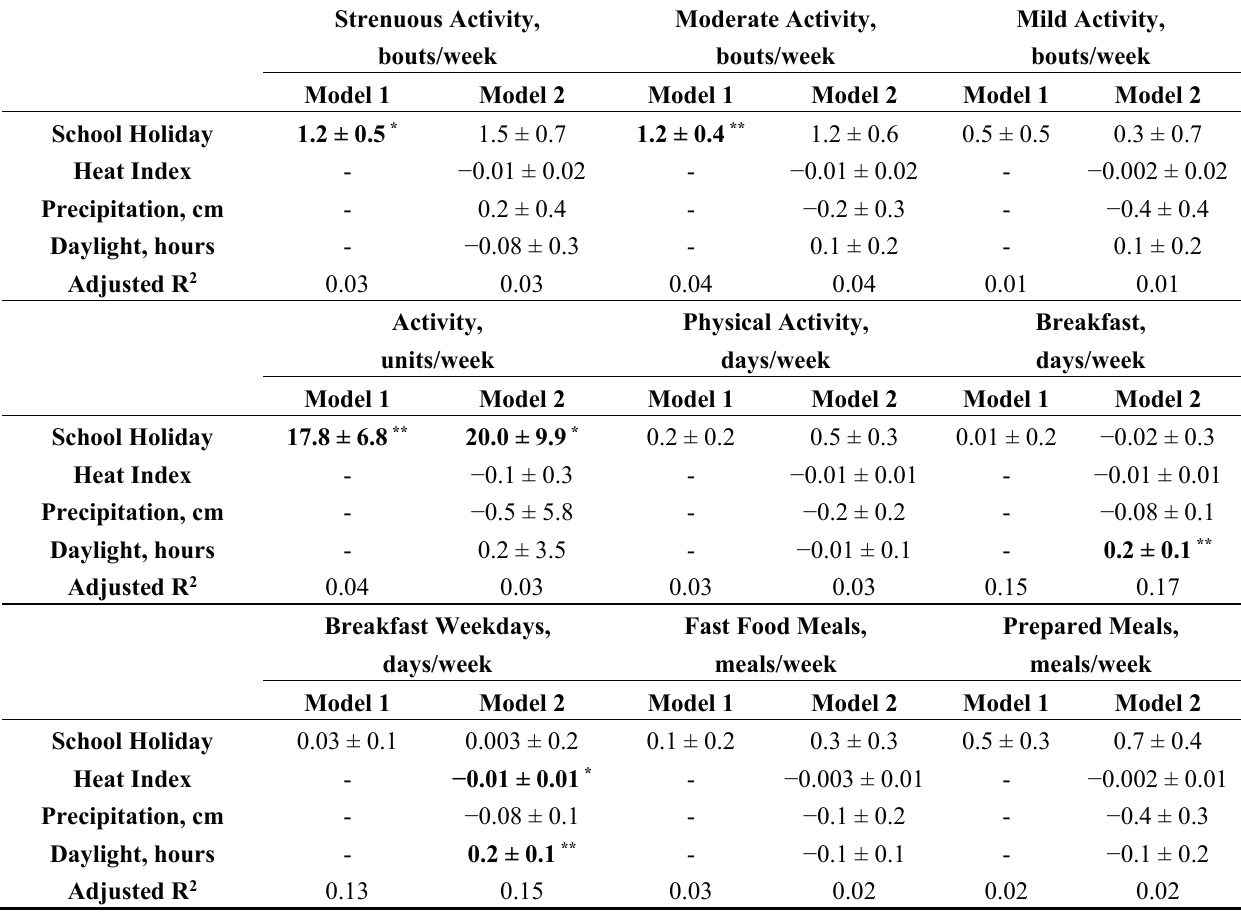
Table 2. Results of multivariable regression examining associations of school holiday with lifestyle habits over a week.